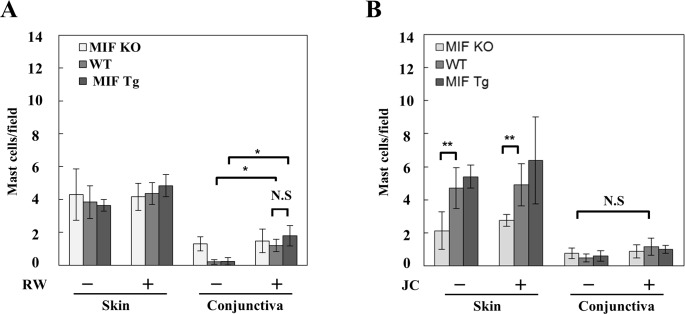
The number of mast cells in conjunctiva and eyelid skin site following active immunization by RW and JC pollen.The number of mast cells in (A) RW and (B) JC pollen-sensitized conjunctiva and eyelid skin sites of MIF KO and MIF Tg mice were compared with those in WT mice. Each value represents the mean ± SD (n = 5 in each group, *P<0.05, **P<0.01). The Student's t-test was used.